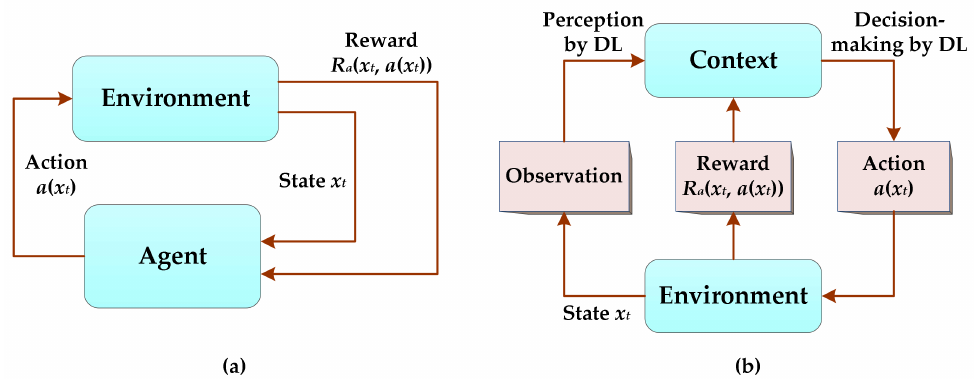
Figure 12. Principle framework diagram of RL and deep RL. ( a ) is the principle framework of RL; ( b ) is the principle framework of deep RL